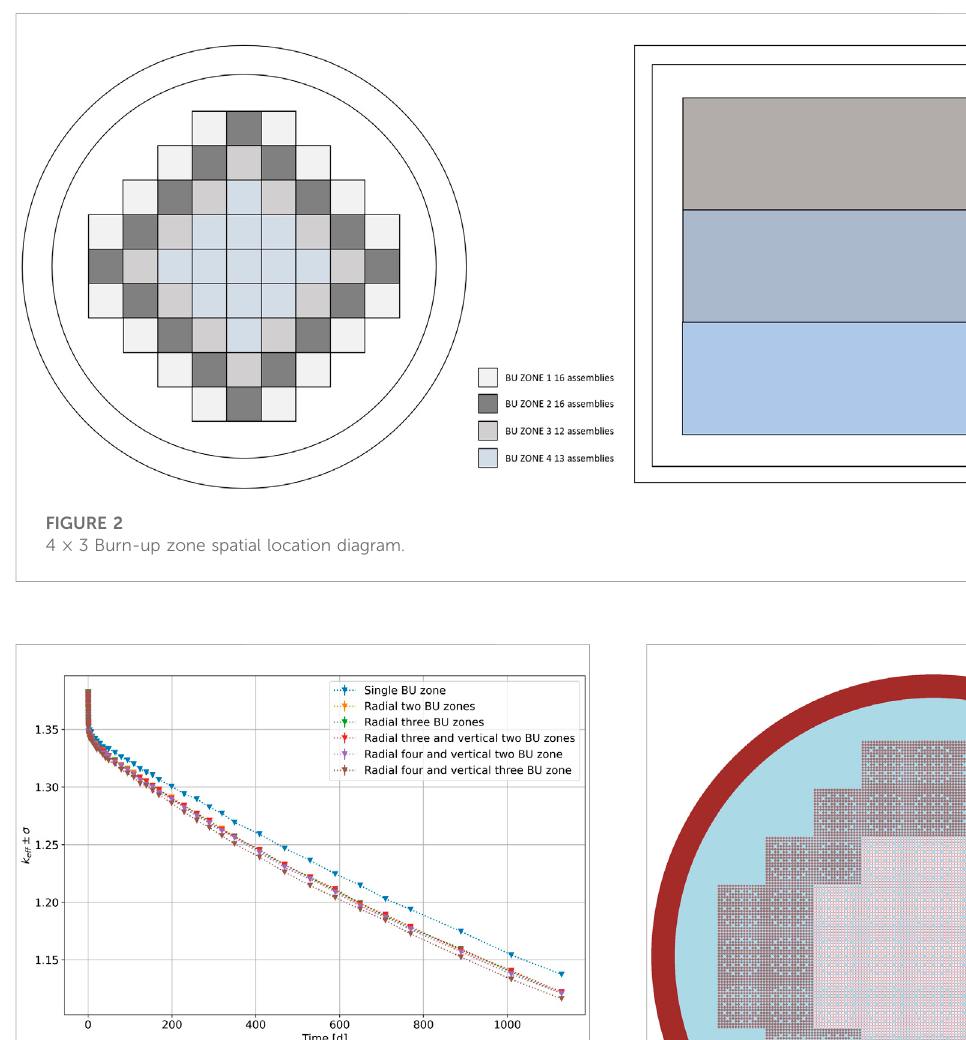
FIGURE 3 The k eff variations in several burn-up calculations with the different number of spatial zones.